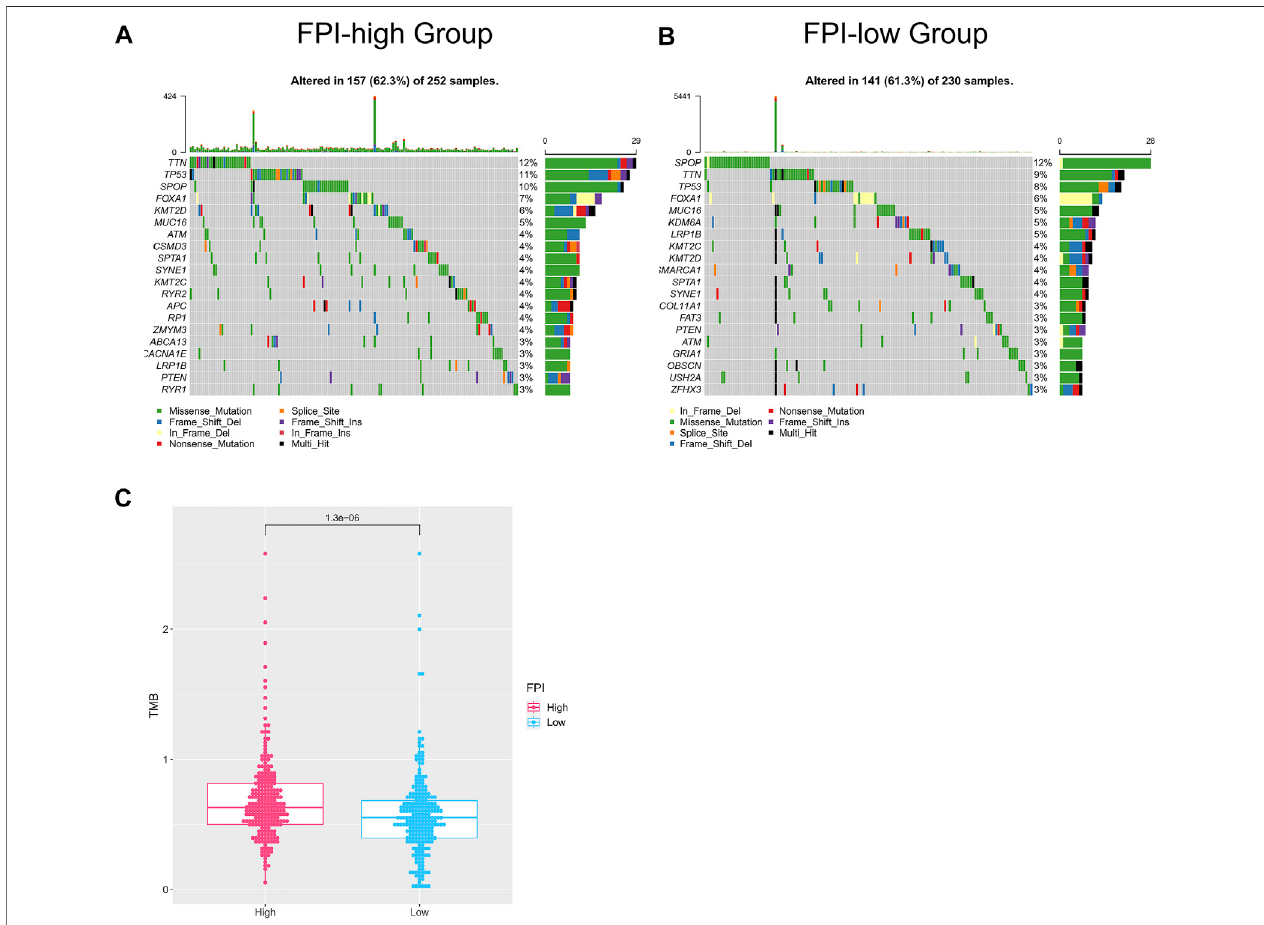
FIGURE2| MutatedgenesintheFPI-highgroupandFPI-lowgroup. (A,B) Waterfallplotofthetop20mutatedgenes( X -axisforsamples, Y -axisformutatedgenes, different colors represent mutation types); (C) TMB of the FPI-high and FPI-low groups.